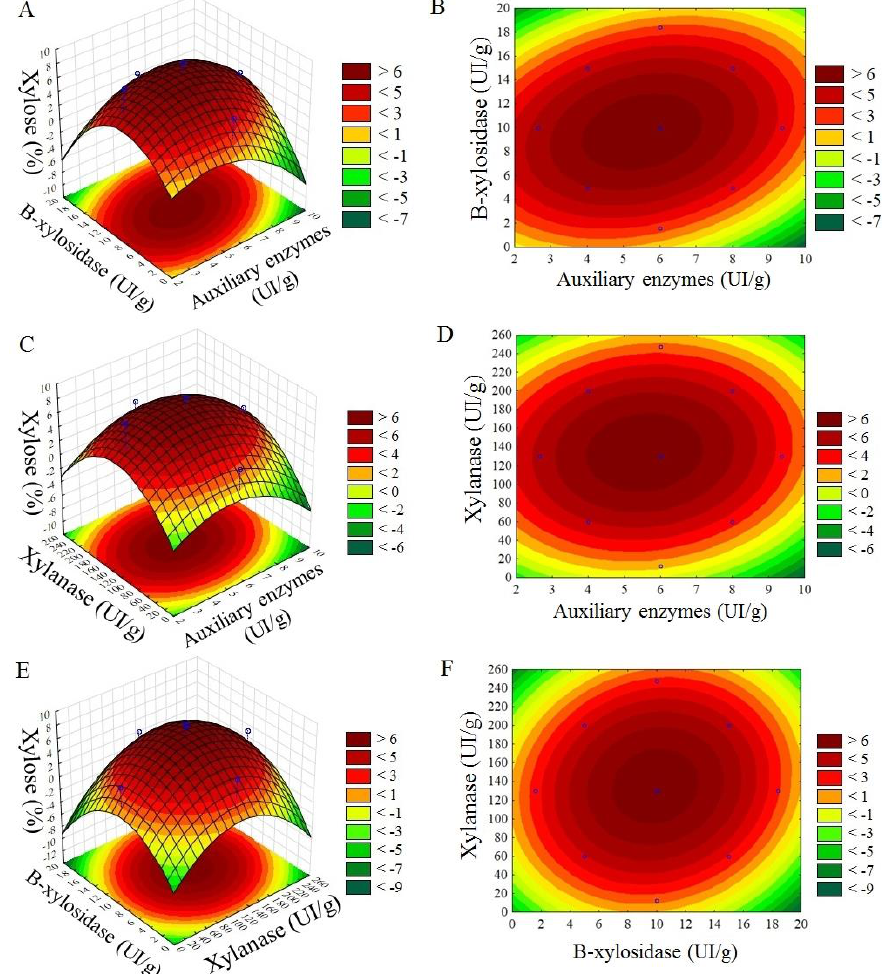
Figure 1. Response surface of xylose yield (%) with xylanase (IU/g), β -xylosidase (IU/g), and auxil- iary enzymes (IU/g) variables. ( A , B ) β -xylosidase (IU/g) and auxiliary enzymes (IU/g) variables; ( C , D ) xylanase (IU/g) and auxiliary enzymes (IU/g) variables; ( E , F ) xylanase (IU/g) and β -xylosidase (IU/g) variables. For all the surfaces, the fixed variable was employed at the intermediate level (central point level). A high yield and concentration of xylooligosaccharides (93.1% and 19.6 g/L, respec- tively) were also observed in the experimental design of the complete xylan hydrolysis (Table 1). It is important to highlight that even in the presence of β -xylosidase, this cocktail presented better results in obtaining xylooligosaccharides than the experimental design itself, which used an enzyme cocktail with the absence of β -xylosidase, since the production of xylose was not the target of the analysis. Hypothetically, a higher β -xylosidase load could lead to higher xylose production (in yield and concentration), thus reducing XOS production (yield and concentration). On the other hand, the xylose was not increased, and probably a higher amount of β -xylosidase could be